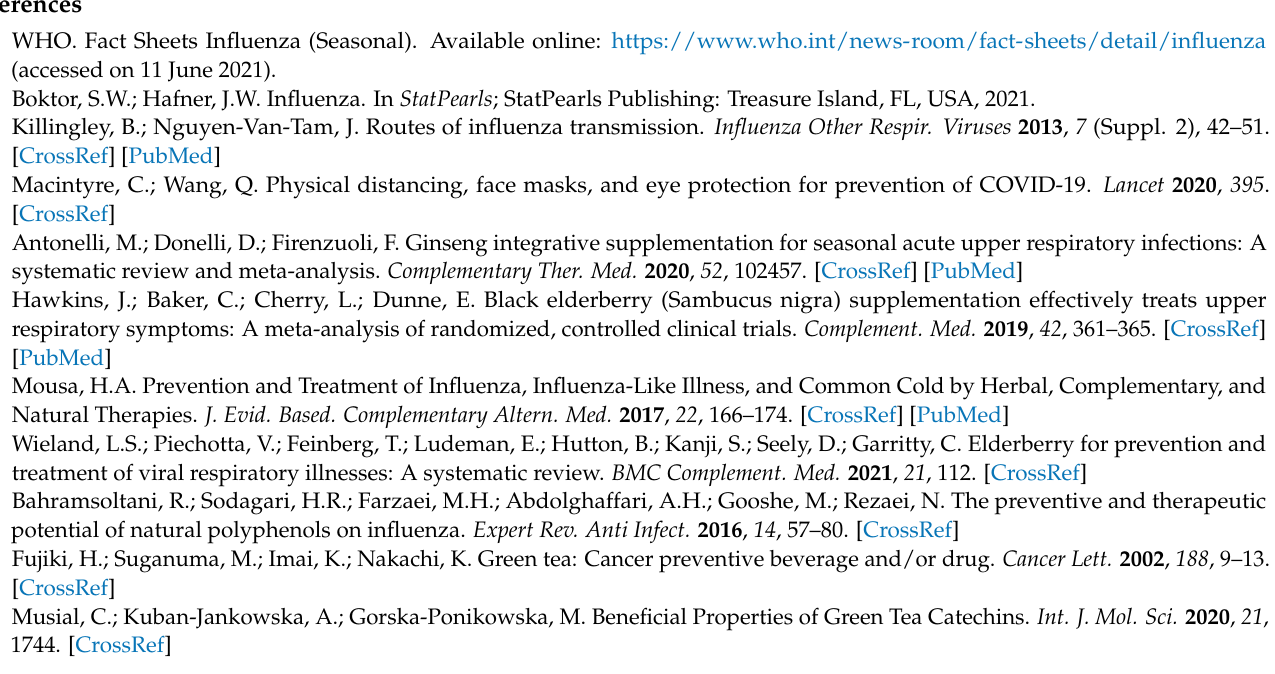
Supplementary Materials: Figure S1: Funnel plot with pseudo 95% confidence limits, Table S1: Event of type of influenza virus infection and EGCG consumption concentrations, Table S2; The Risk Of Bias In Non-randomized Studies of Interventions (ROBINS-I) tool, Table S3: The PRISMA statement